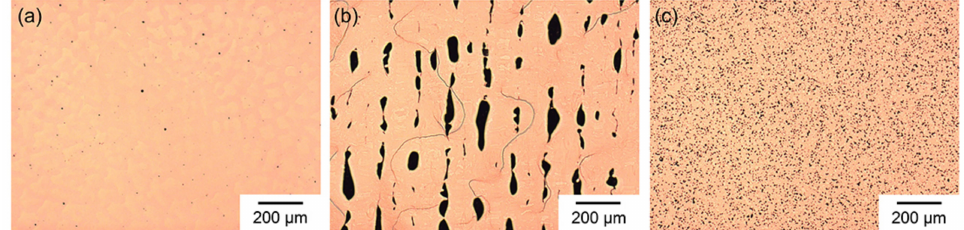
Figure 3. Optical microscopy images (magnification = 50 × ) of Ni–Cr–Mo alloys: LWC ( a ), SLM ( b ), and SMM ( c ). Red arrow in ( b ) indicates SLM building